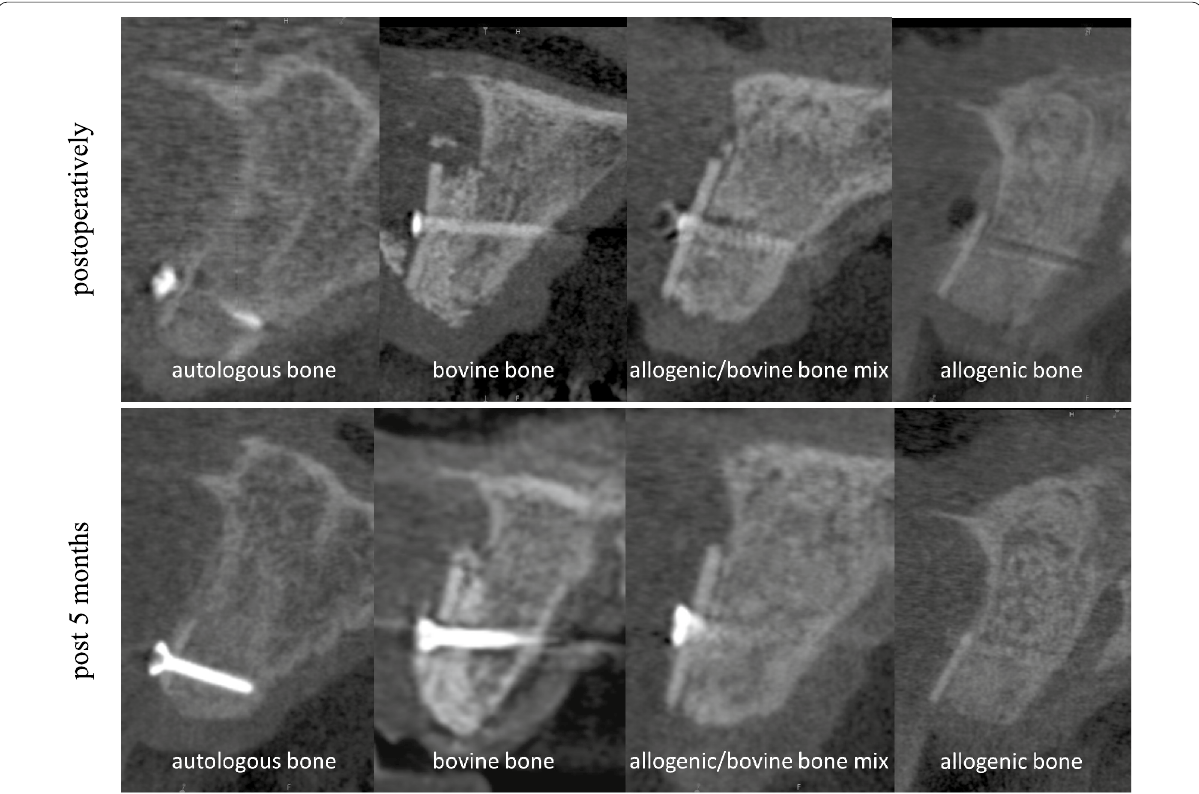
Fig. 7 Alveolar ridge augmentation with different fillings, autologous bone, bovine substitute, a mixture of allogeneic bone and bovine substitute, and allogeneic bone at CBCT scans. Upper line situation postoperatively and lower line situation after 5 months in CBCT scans